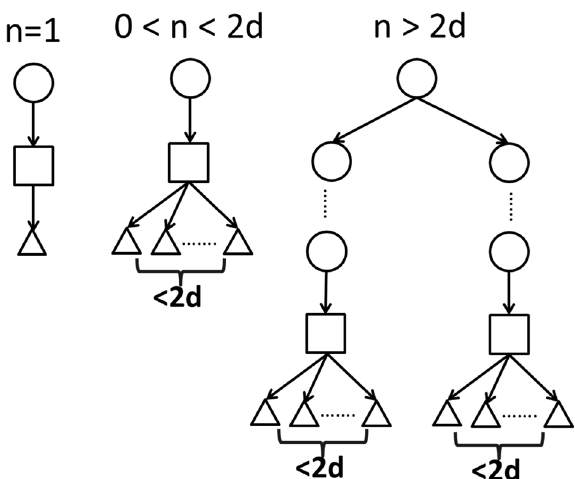
Fig. 5 Build initial SKDTree. In the figure 5, the circles represent non‑leaf nodes, the squares representsub‑leaf nodes and the triangles represent leaf nodes in